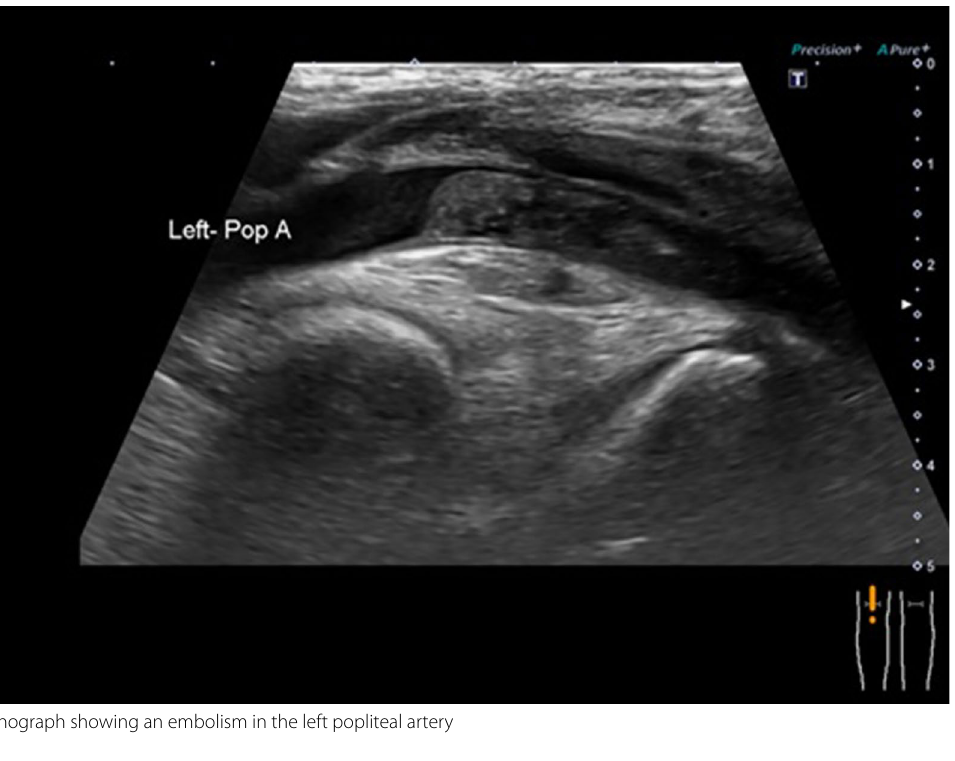
Fig. 5 Ultrasonograph showing an embolism in the left popliteal artery